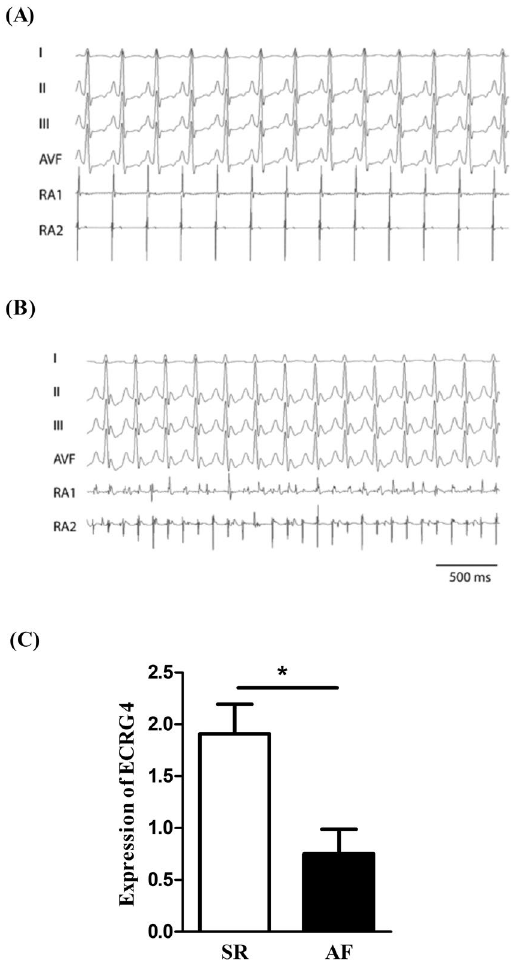
Figure 5. Establishment of canine AF model and expression of Ecrg4 in atria. AF was induced in canines using rapid atria pacing as described in materials and methods. AF was confirmed using surface and intracardiac electrograms showing a normal regular P and atrial waves ( A ) in a control dog relative to fast and irregular atrial waves ( B ) in an AF model dog. When gene expression was analyzed by real-time PCR ( C ), ECRG4 was significantly down-regulated (n = 8, P < 0.05) in AF models (AF, black bar) compared to controls in SR (SR, Open Bar). Data were presented as “Mean ± SD”, and the experiments were performed in triplicate and repeated three